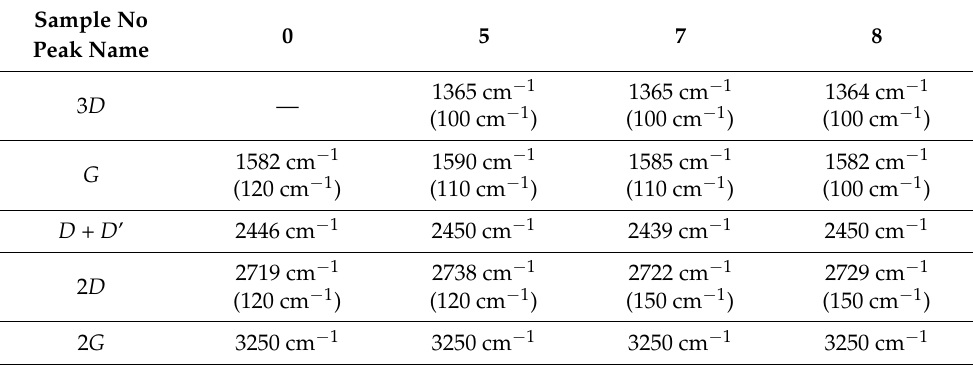
Table 1. Spectral line energy positions (and width) (cm − 1 ) in the Raman spectra of Chelyabinsk meteorite